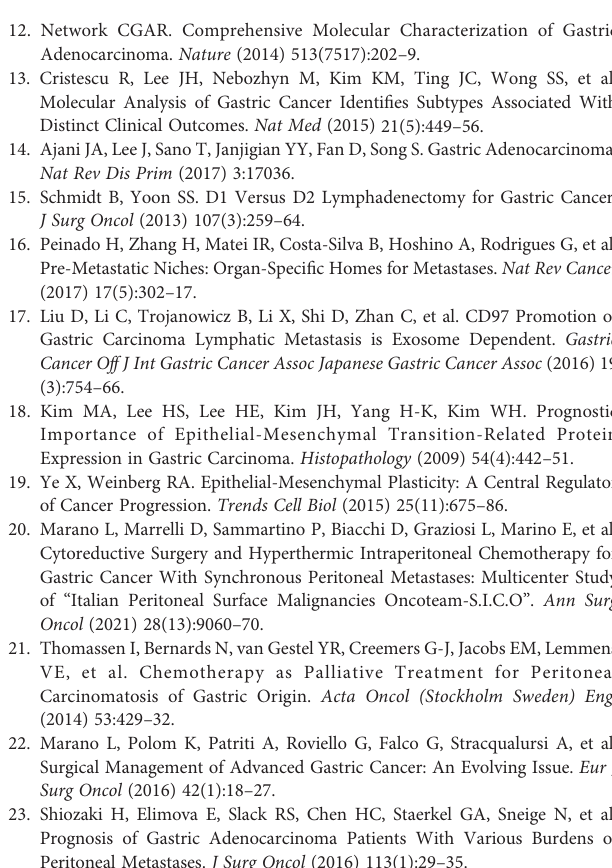
Supplementary Figure 1 | MKN45 cells were serum-starved and left untreated orprimed withLIF (10,50,100 ng/ml). Data shown are: (A) MTS assay. Each value is expressed relative to those of non-treated (NT), which are arbitrarily settled to 1. Resultsarethemean±SEMof10samplespergroup.RelativemRNAexpressionof (B) the proliferation marker C-myc and EMT markers E-cadherin, Snal-1, and vimentin. Each value is normalized to Gapdh and is expressed relative to those of NT,whicharearbitrarilysettledto1.Resultsarethemean±SEMof fi vesamplesper group (* represents statistical signi fi cance versus NT, and # versus LIF, p<0.05). Cell cycle phase analysis were performed by Ki-67/DAPI staining through IC-FACS analysis. Data shown are: percentage of (D) Representative IC-FACS showed cell cycle fraction and apoptosis rate in NT, LIF (10 ng/ml), EC359 (25 nM), and LIF + EC359. (E) cell in G0-G1 cell cycle phases, S-G2-M cell cycle phases, and ratio between % G0-G1 and % S-G2-M. (F) Percentage of Apoptotic cells. Results are the mean±SEM of three samples per group (* represents statistical signi fi cance versus NT, and # versus LIF,